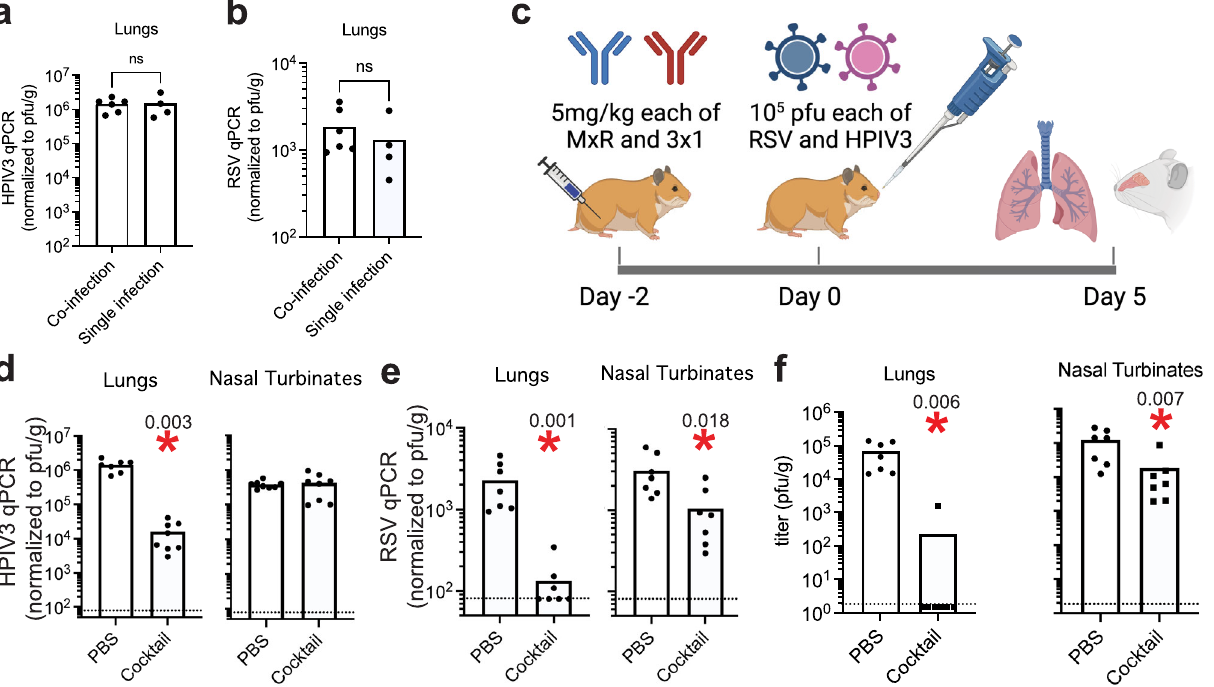
Fig. 6 | Ef fi cacy of prophylactic administration of a cocktail of 3×1 and MxR against HPIV3 and RSV co-infection in vivo. The speci fi c viral load of HPIV3 ( a ) and RSV( b ) in lung homogenates of hamsters co-infected with 10 5 pfu each ofRSV andHPIV3wascomparedtohamstersinfectedwith10 5 pfuofasinglevirusbyreal- time PCR: n =4 animals/single infection and n =6 for the co-infection. c Schematic ofexperimentsinwhichhamsterswereinjectedintramuscularlywith5mg/kgeach of 3×1 and MxR as a cocktail two days prior to intranasal challenge with 10 5 pfu each of HPIV3 and RSV.The speci fi c viral load of HPIV3 ( d ) and RSV ( e ) in lung and nasal tissue homogenates wasdetermined by real-time PCR using HPIV3- and RSV-